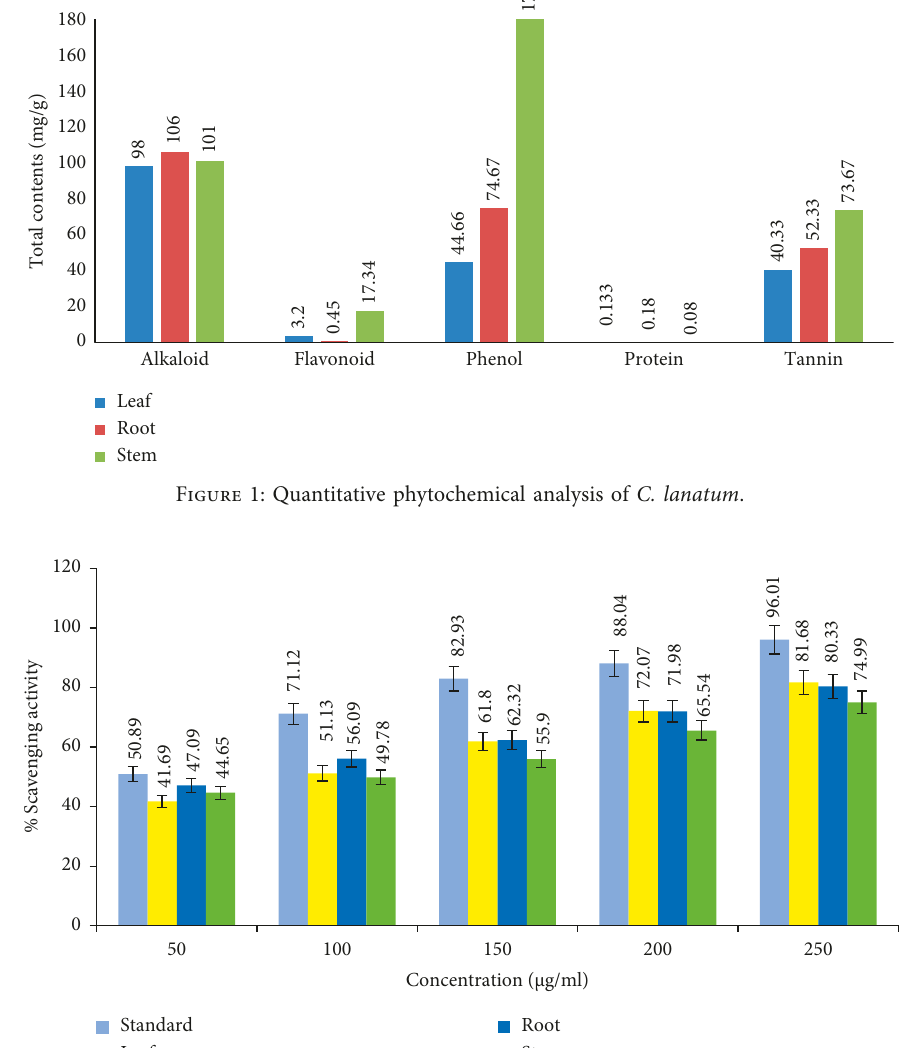
Figure 2: Antioxidant activity of leaves, root, and stems of C. lanatum with the standard (ascorbic acid).